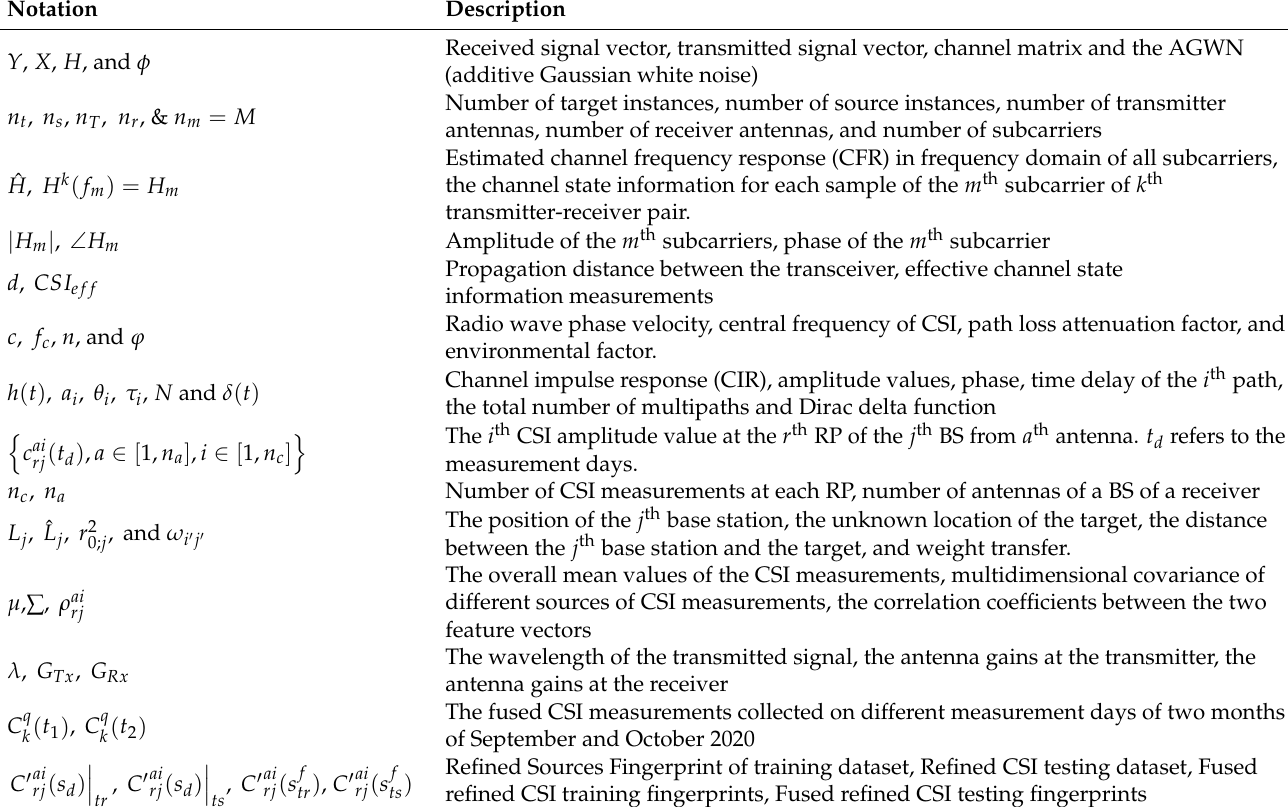
Table 1. List of